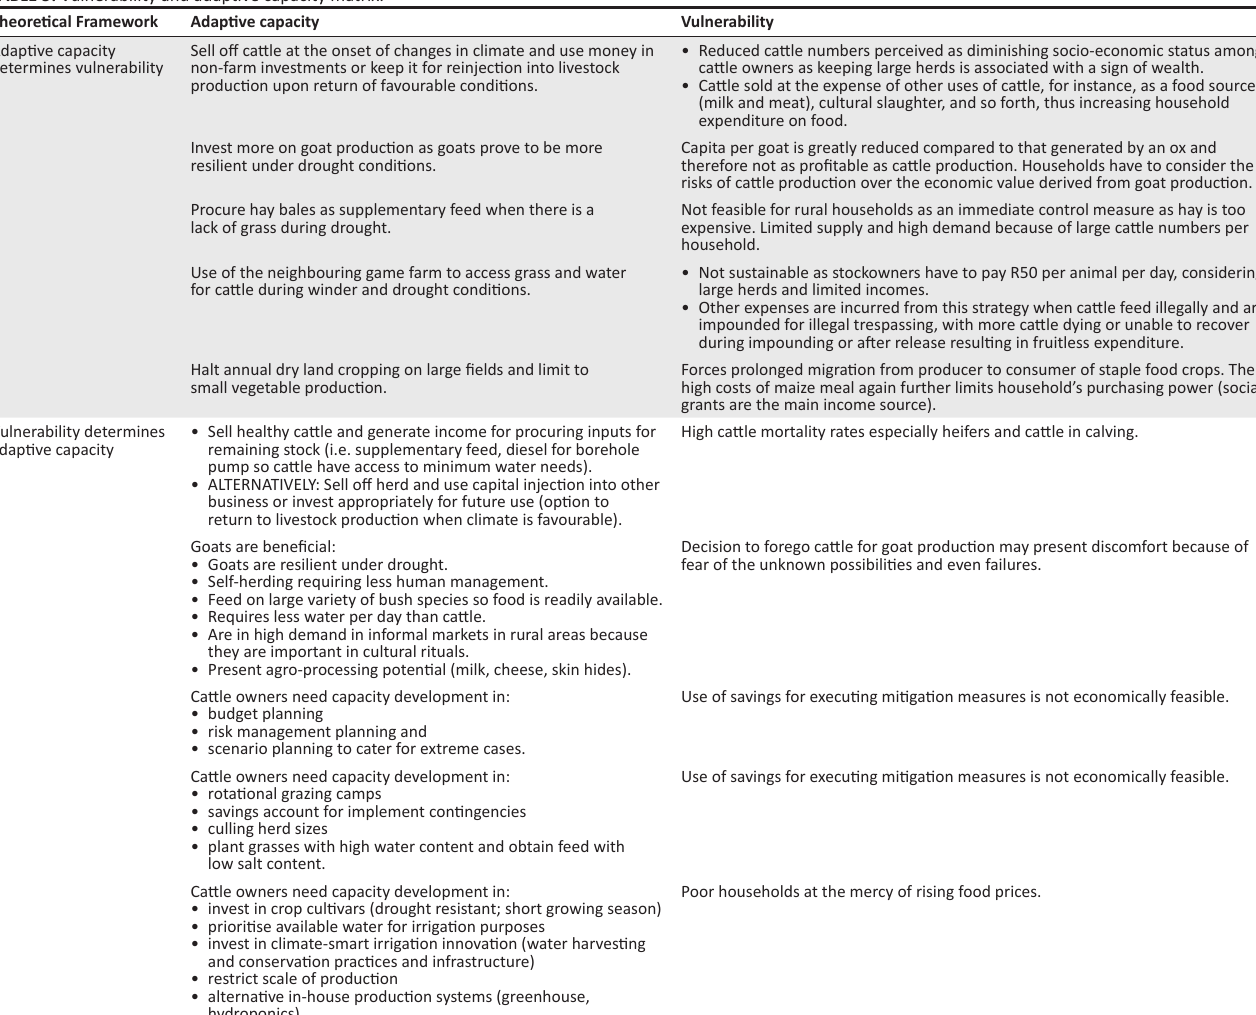
TABLE 5: Vulnerability and adaptive capacity